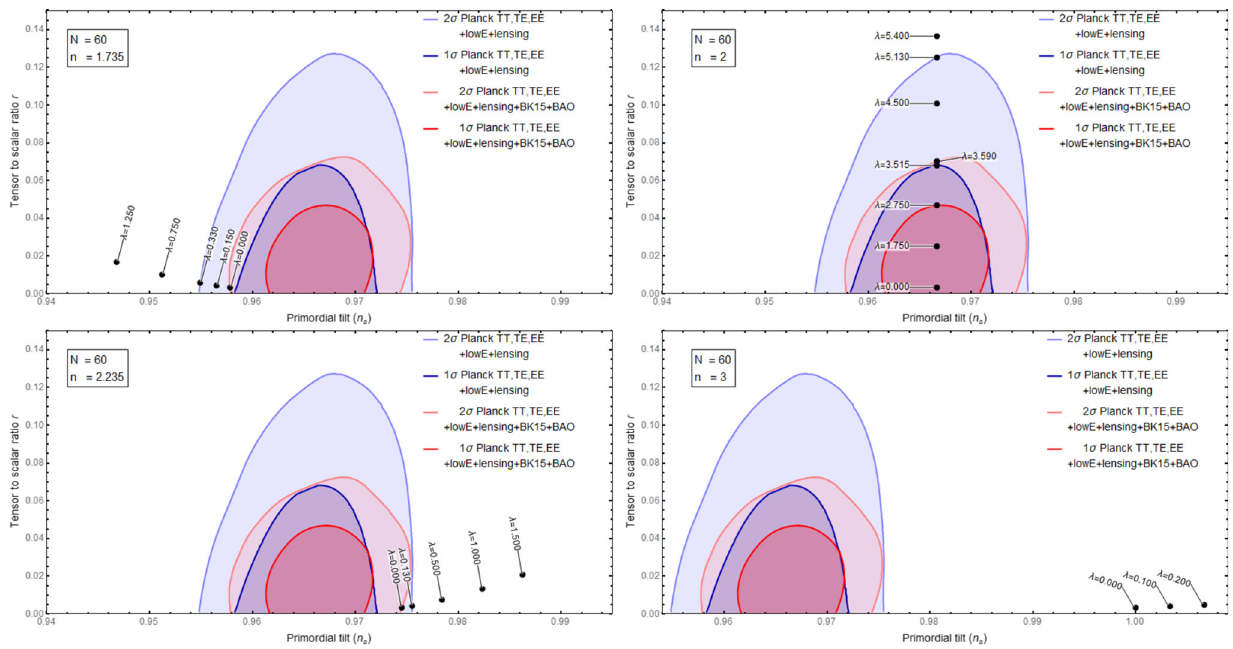
Fig. 1 We compare the theoretical predictions in the ( r − n s ) plane for different values of λ using N = 60 and varying n . We plots for N = 60 , n = 1 . 735 (upper-left panel); N = 60 , n = 2 (upper-right panel);